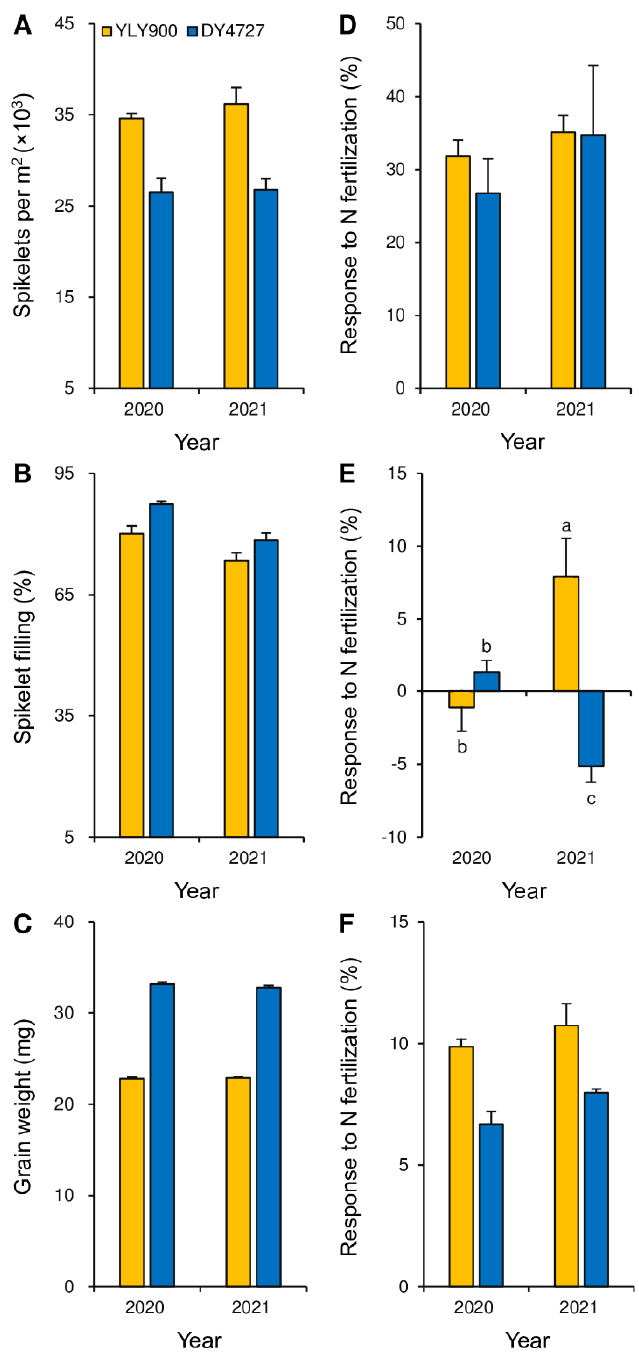
Figure 3. Spikelets per m 2 ( A ), spikelet filling percentage ( B ), and grain weight ( C ) under the zero-N fertilization condition and their responses to N fertilization (180 kg N ha − 1 ) relativized to zero-N fertilization ( D – F ) in two hybrid rice varieties, Deyou 4727 (DY4727) and Y-liangyou 900 (YLY900), grown in 2020 and 2021. Data are means (columns) and standard errors (bars) of three replications. In ( E ), means not sharing any letter are significantly different at the 0.05 probability level.